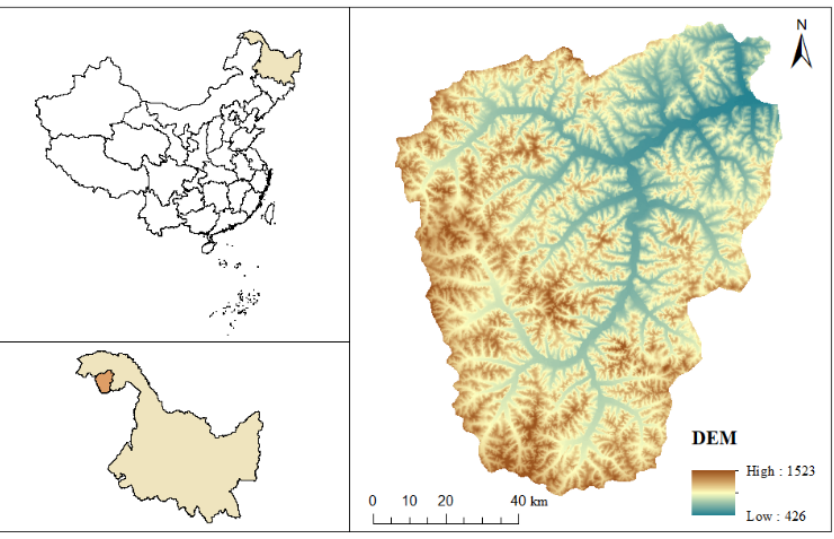
Figure 1. The geographic location of the Huzhong Forest.